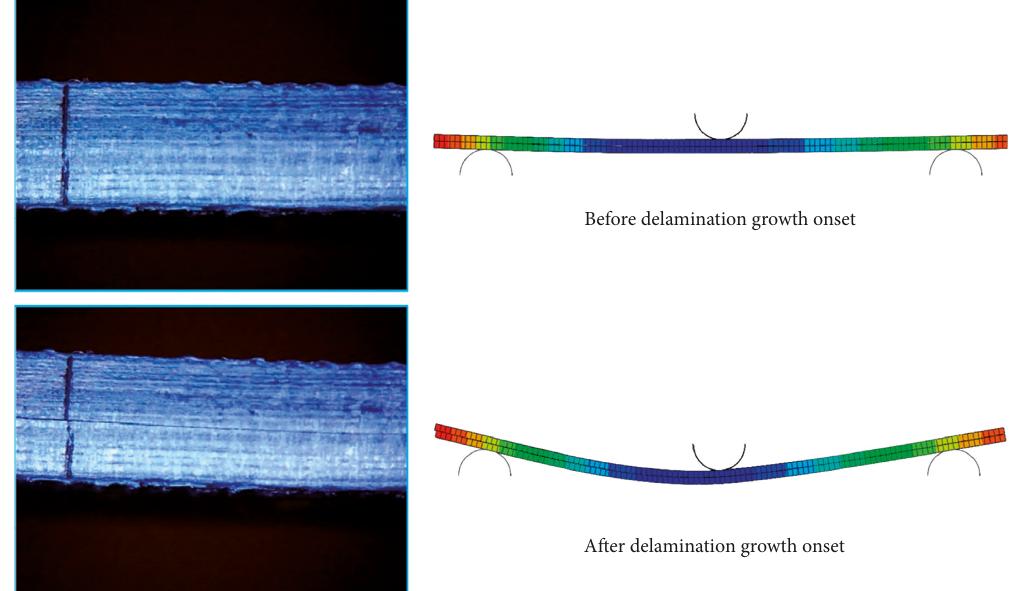
Figure 26: ENF: experimental and numerical deformed